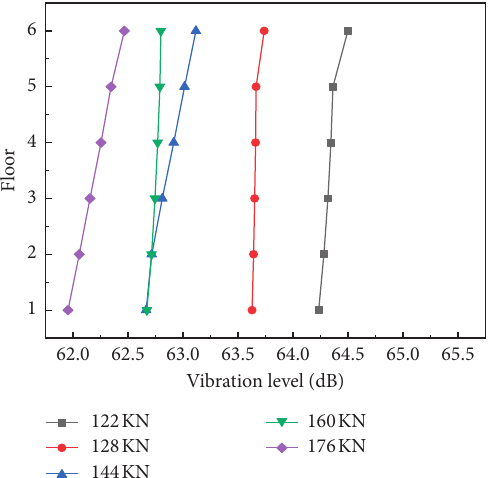
Figure 7: Building vibration with different floors under different axle loads.